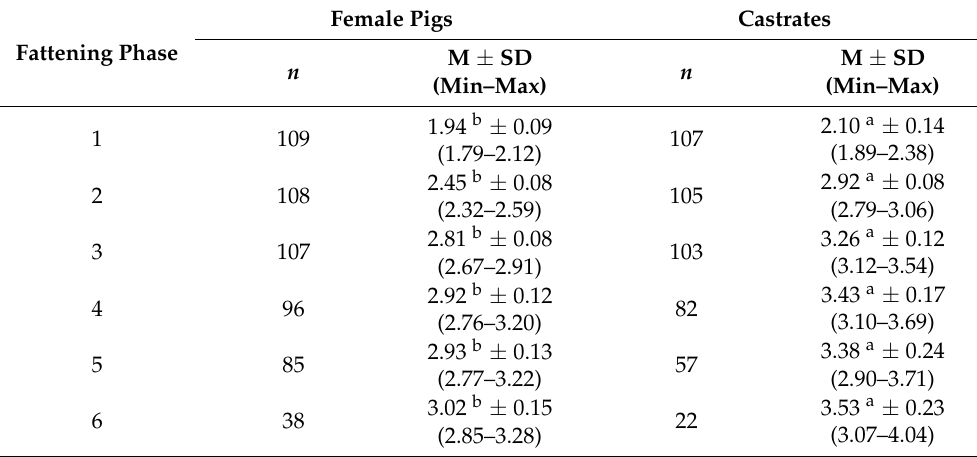
Table 3. Average feed intake (kg/animal/day) during the fattening period.